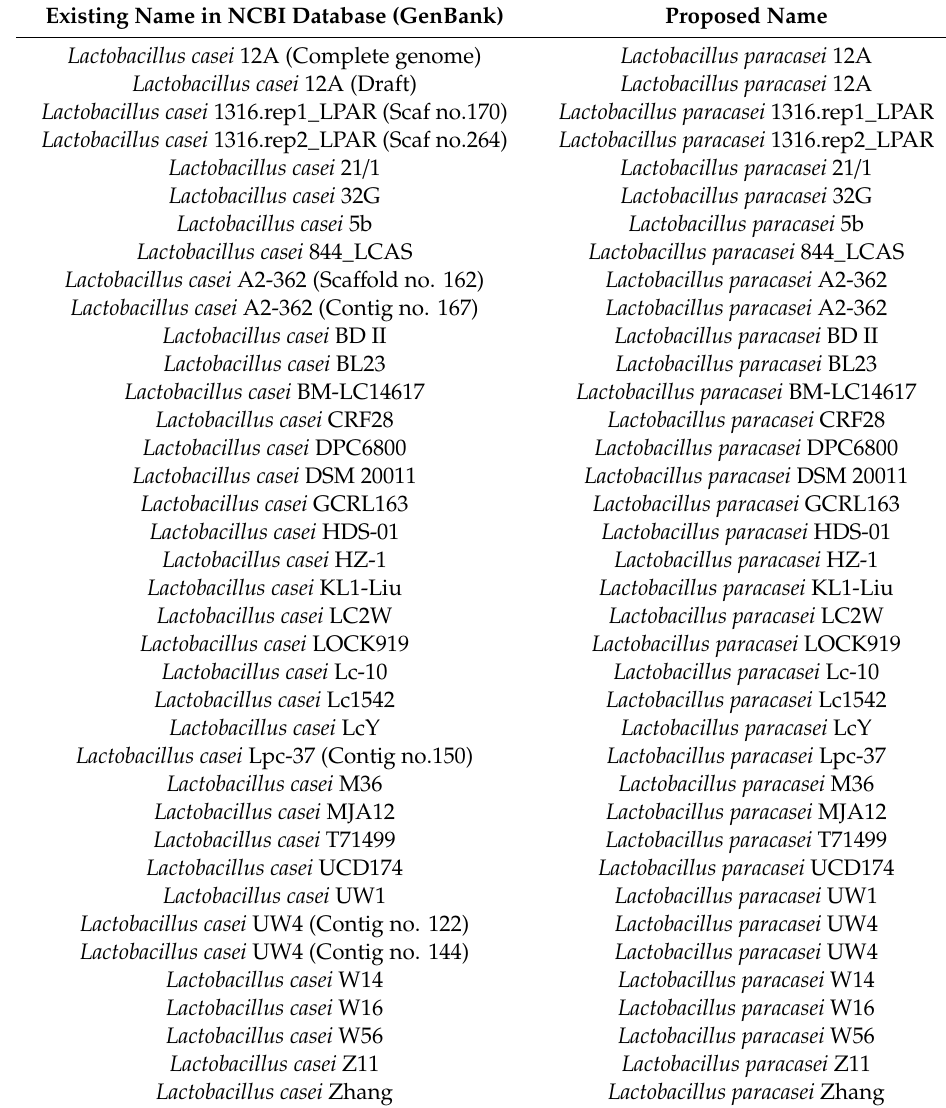
Table 1. Proposed name of L. casei strains based on the Average Nucleotide Identity (ANI) and Average Amino Acid Identity (AAI)